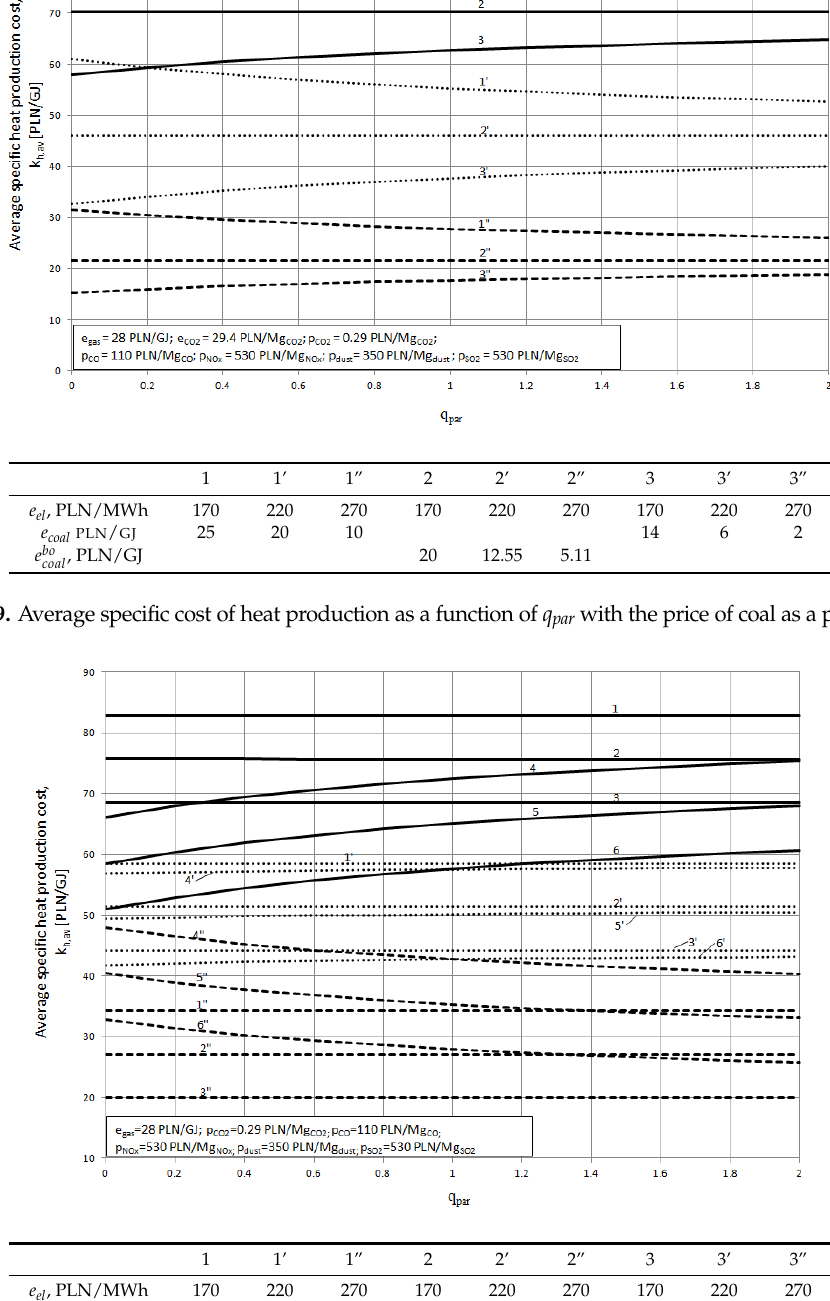
Figure 10. Average specific cost of heat production as a function of q par with the purchase price of carbon dioxide emission allowances as a parameter, where: